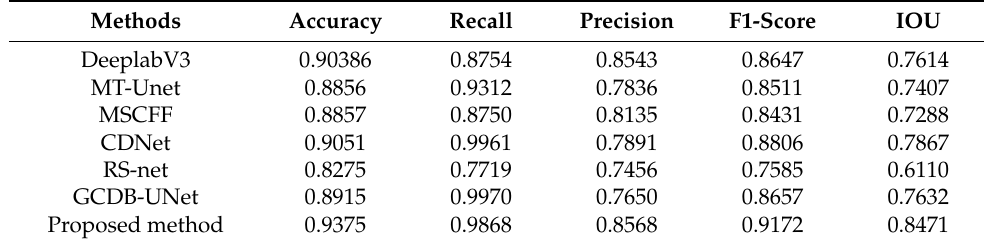
Table 6. Comparison of deep learning based cloud detection methods quantitative accuracy.